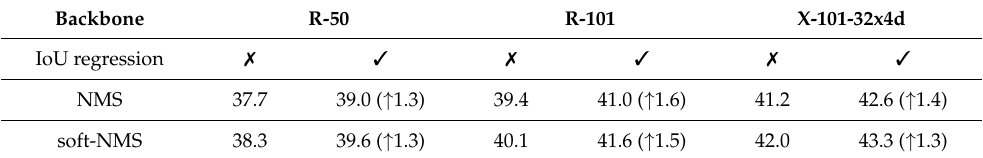
Table 5. The effect of detection confidence on soft-NMS.